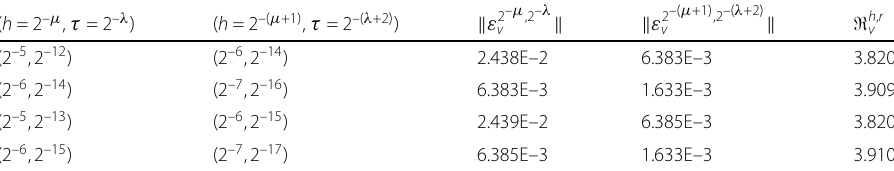
Table 1 Maximum errors and the order of convergence of approximate solution ˜ v with respect to h and τ for Example